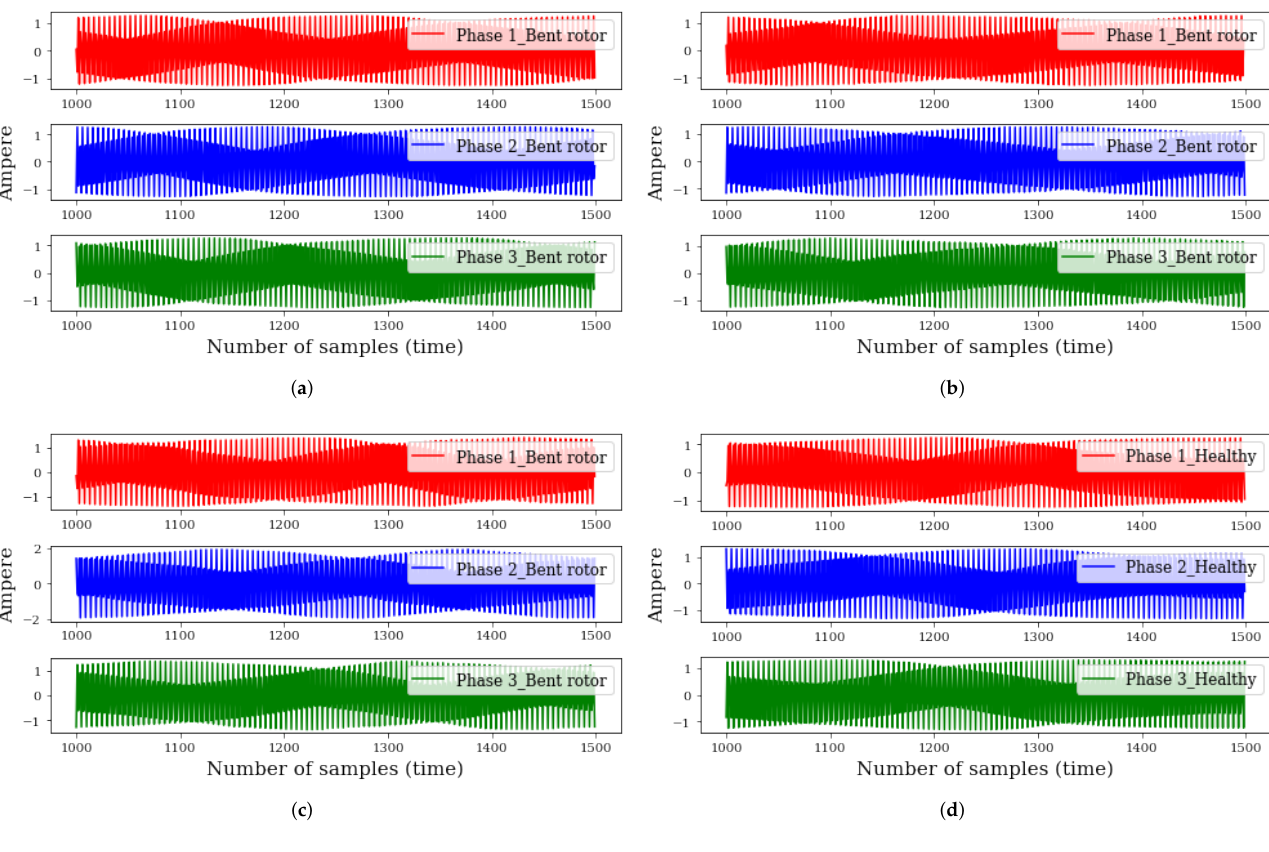
Figure 7. Raw motor current signals plot collected for the squirrel cage induction motors: ( a ) AMT-1,